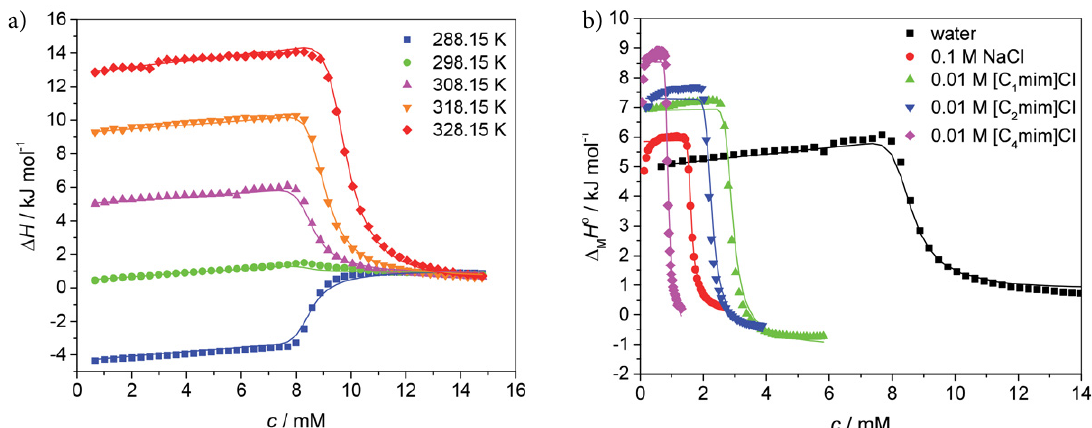
Figure 1. (a) Enthalpograms of SDS titrations in water from 288.15 K to 328.15 K in the step of 10 K and (b) enthalpograms of SDS in all investigat- ed systems at 308.15 K. Symbols represent the experimental data, and solid lines are the best-fits according to two-state mass action model (eq. (5)).